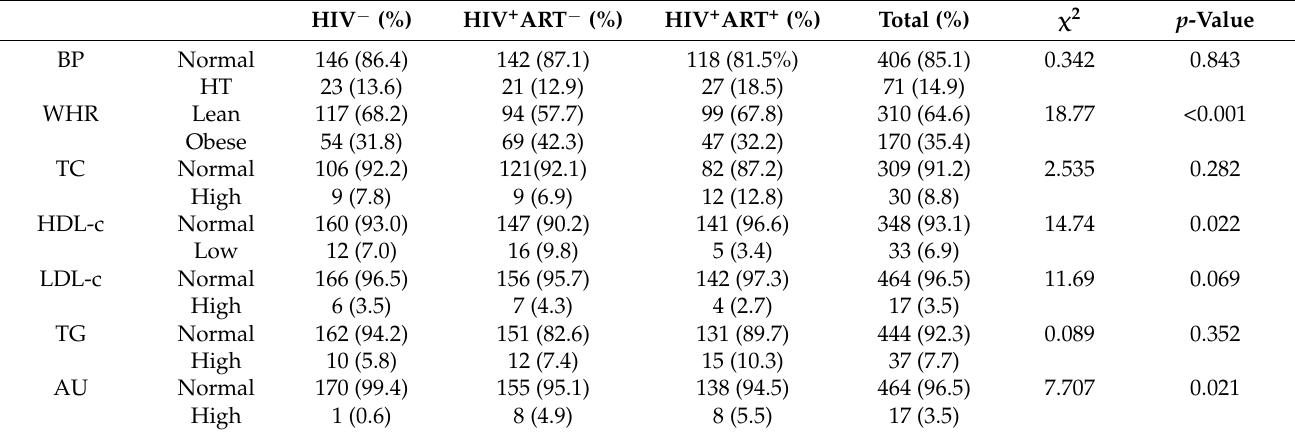
Table 2. Relationship between HIV, ART and cardiovascular risk